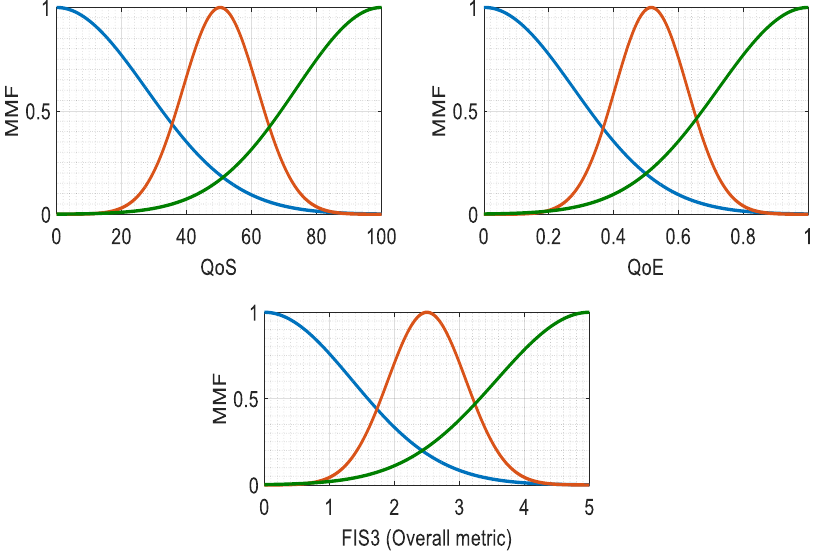
Figure 6. FIS3 membership functions (MMF): Inputs (top) and output (bottom). Table 3. The rules for the FIS3 knowledgebase.